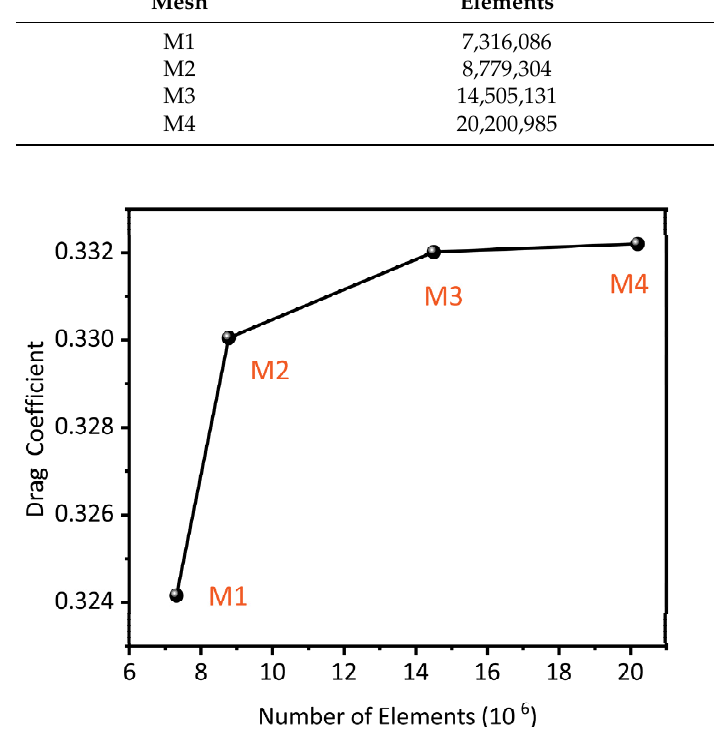
Table 1. The finite element mesh used in simulations and the results of the grid convergence study. Mesh